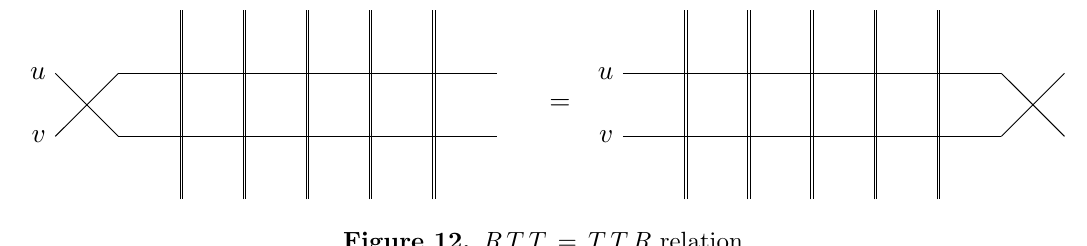
Figure 12. R T T = T T R